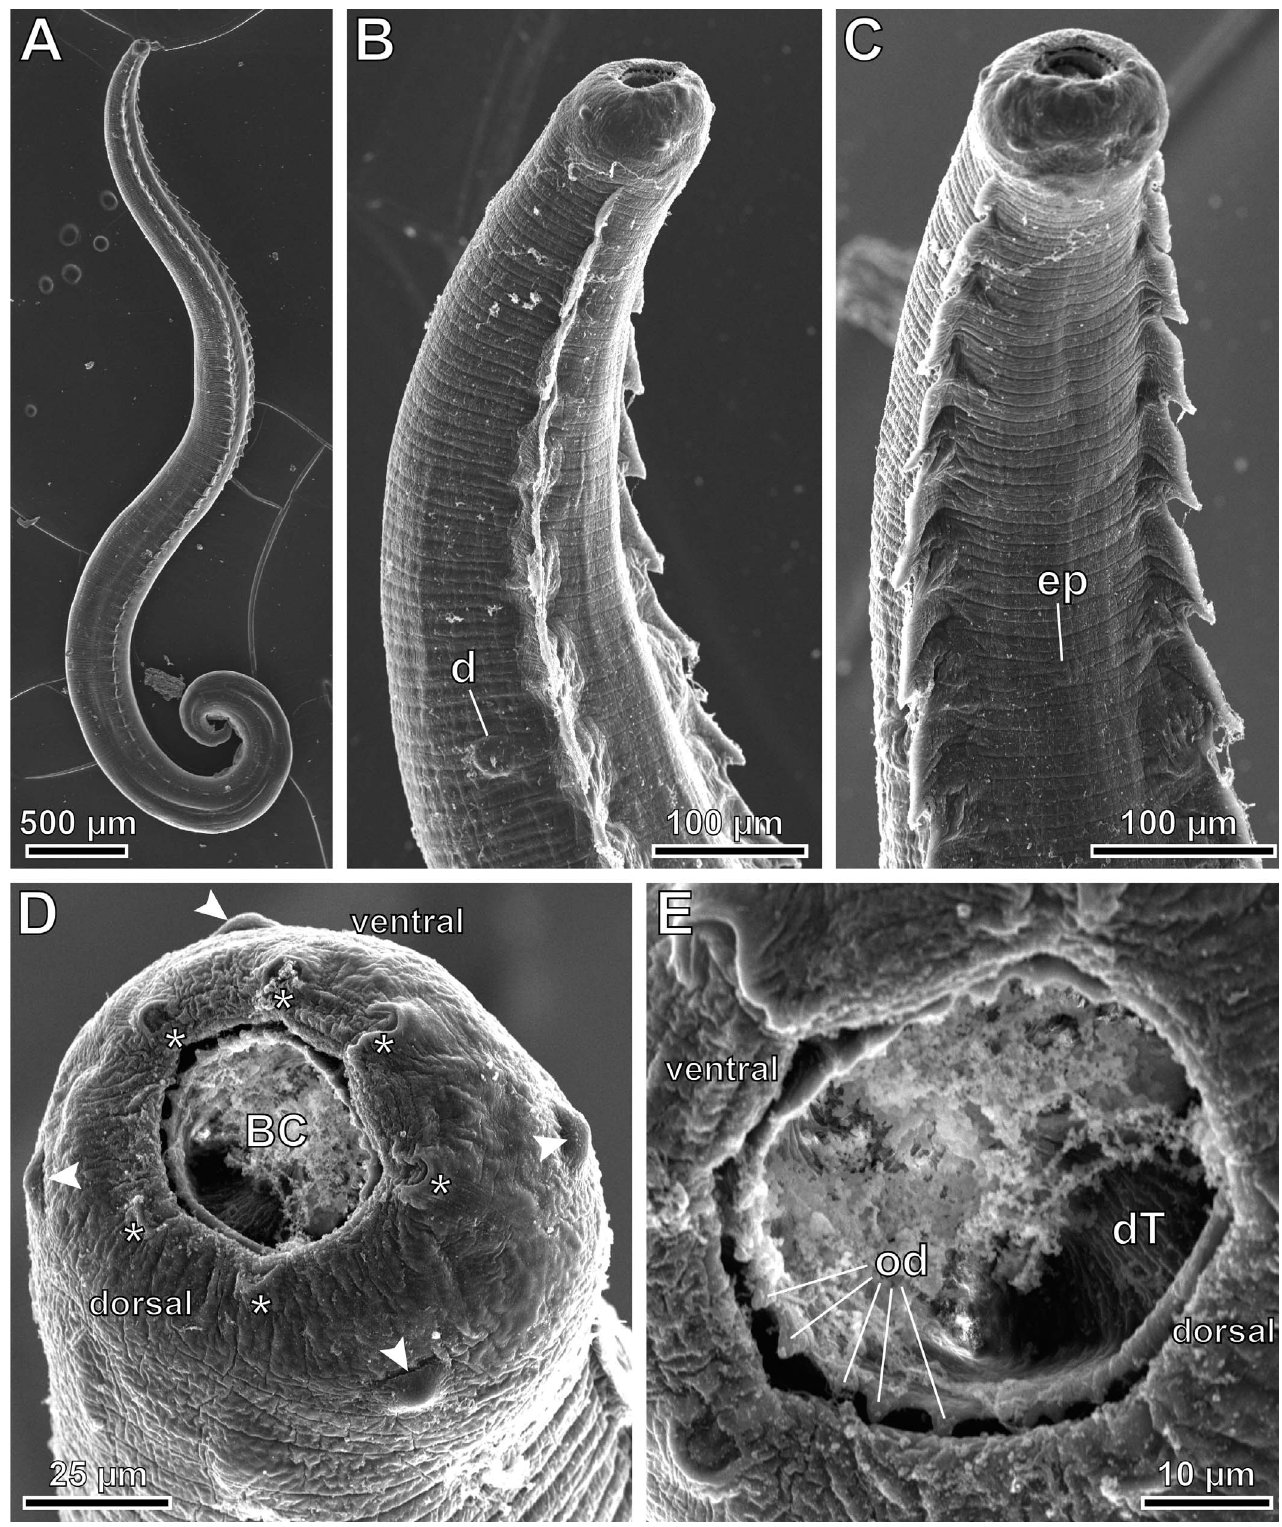
Figure 7. Pterygodermatites ( Mesopectines ) valladaresi n. sp., male, scanning electron microscopy. (A) General view; (B) cephalic extremity, lateral view; (C) cephalic extremity, ventral view; (D) apical view of the cephalic extremity showing labial and cephalic papillae; (E) detail of the buccal capsule showing the oral denticles. *, internal circle of 6 labial papillae; arrowhead, external circle of 4 labial papillae plus 4 cephalic papillae, grouped in pairs; BC, buccal capsule; d, deirid; dT, dorsal oesophageal tooth; ep, excretory pore; od, oral